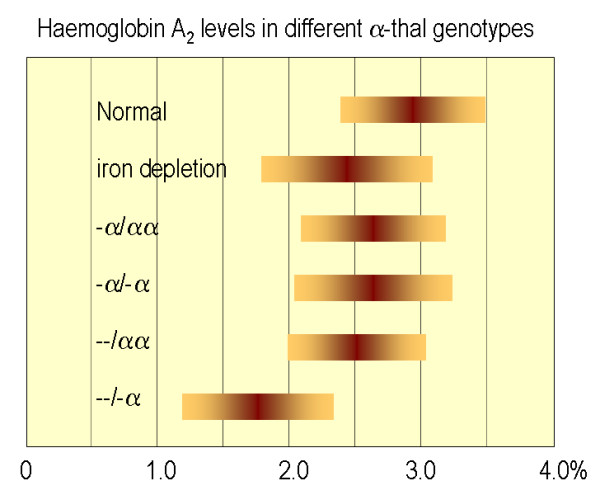
Mean and standard deviation of HbA2 in different α-thalassaemia genotypes.